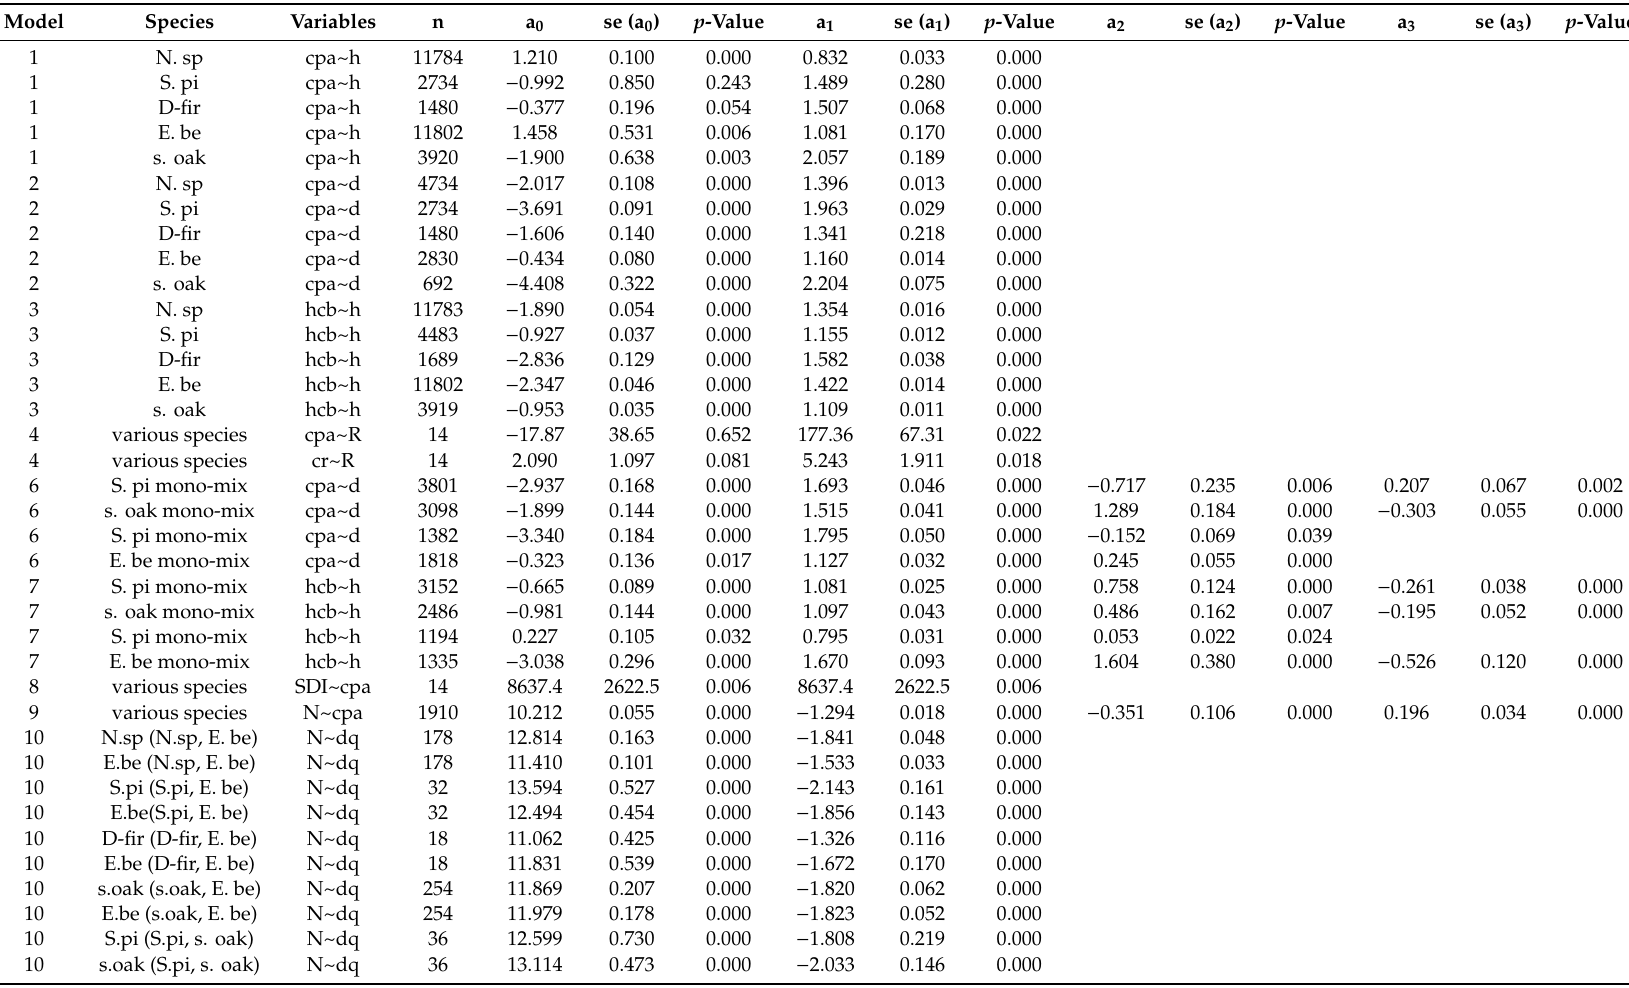
Table 1. Statistical characteristics of the models 1–4 and 6–10. The model numbers refer to Section 2.4 where the models are introduced in detail. For the results of model 5, see Supplementary Table S1. For reasons of space, the table reports onl the fixed e ff ect variables of the respective models. se is the standard